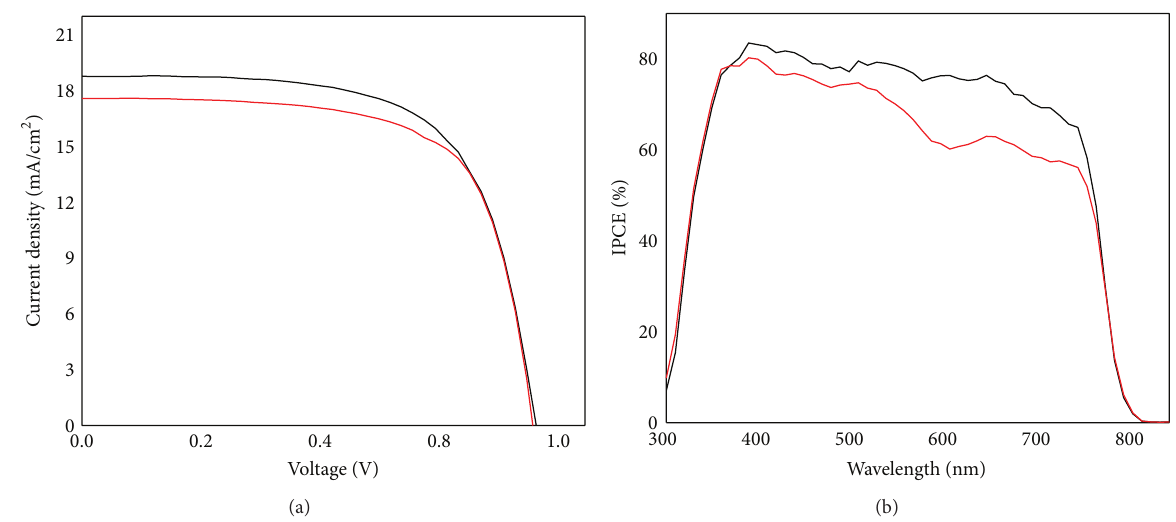
Figure 9: (a) 𝐽 - 𝑉 curves and (b) IPCE spectra of vapor deposited (red line) versus spin-coated (black line) PbI 2 layers in a perovskite cell. Reproduced from [23] with permission from the Royal Society of Chemistry.